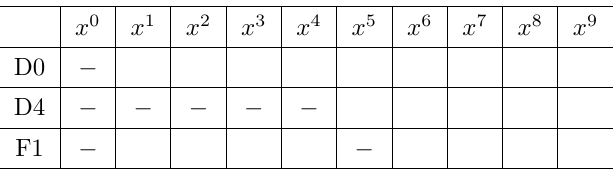
Table 2 . Brane set-up associated to the D0-D4-F1 brane system T-dual to the D1-D5 system.